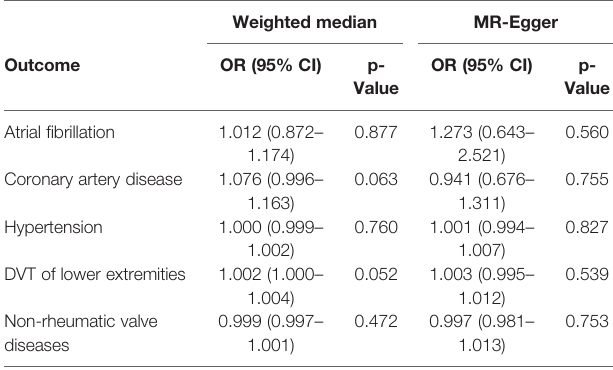
TABLE 3 | Associations between genetically predicted anti-cytomegalovirus IgG levels and 9 CVDs in sensitivity analyses using the weighted median and MR- Egger